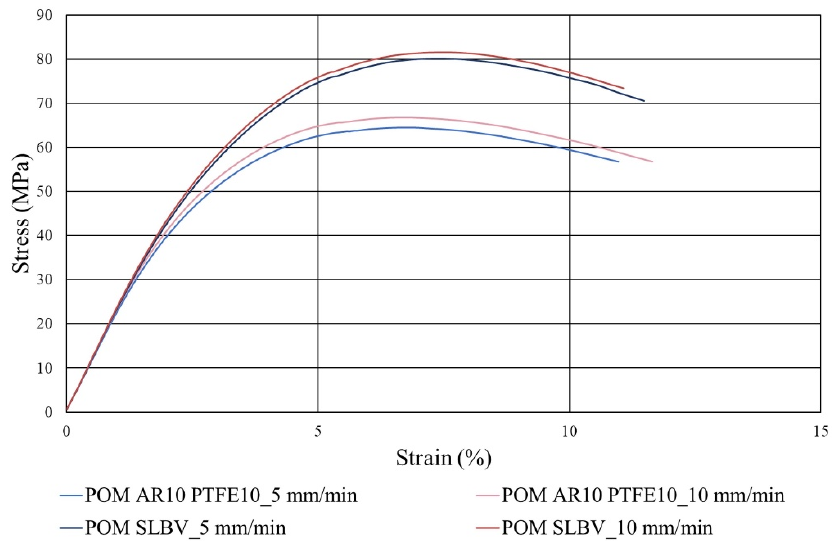
Figure 6. Stress–strain diagram recorded during the three-point bending test according to DIN EN ISO 178, n = 5. Table 4. Mechanical properties of the POM copolymers determined in a tensile test, according to DIN EN ISO 527-1 type 1A.